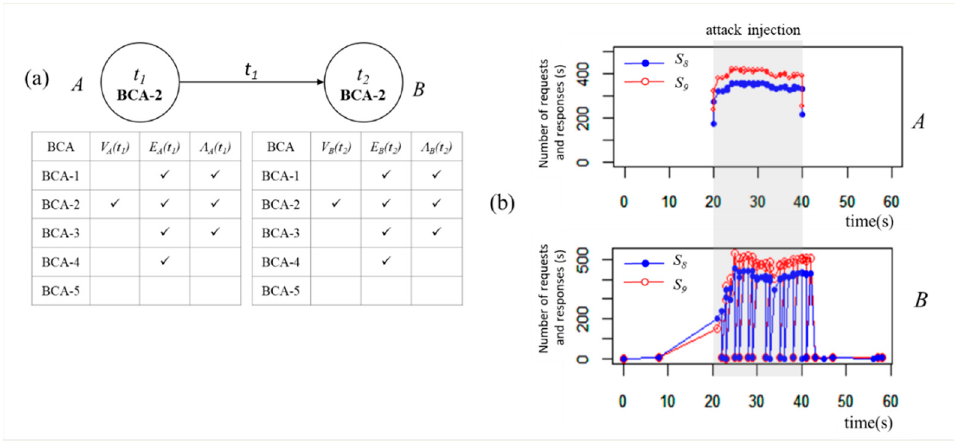
Figure 8. ( a ) Network structure of Scenario 2 and the BCA status of host A and B . ( b ) Experimental results of S 8 and S 9 on host A and B .